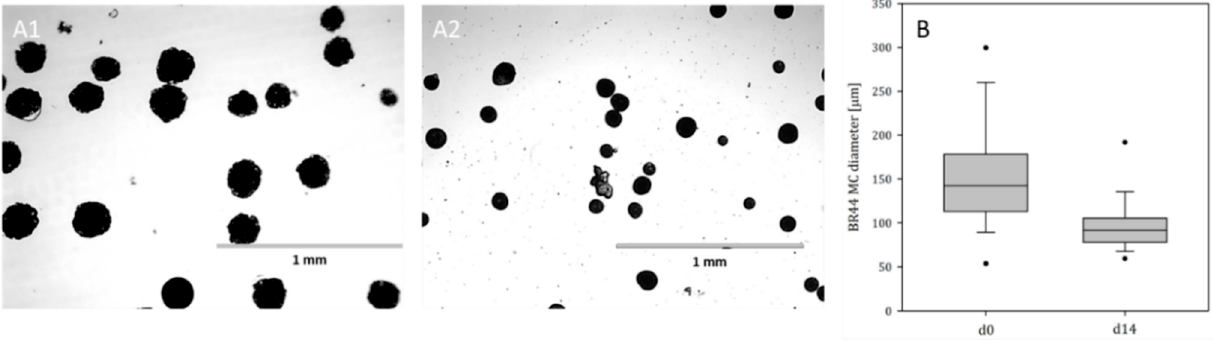
Figure 6. BR44 stability and size distribution. ( A1 , A2 ) Phase-contrast light microscopic pictures of the BR44 MC during the stability test in the Corning spinner flask ( N = N s1u ) at day zero and 14. ( B ) Size distribution after equilibration (4 h) of the BR44 MC in UrSuppe (day 0) and after 14 days incubation under stirred conditions.